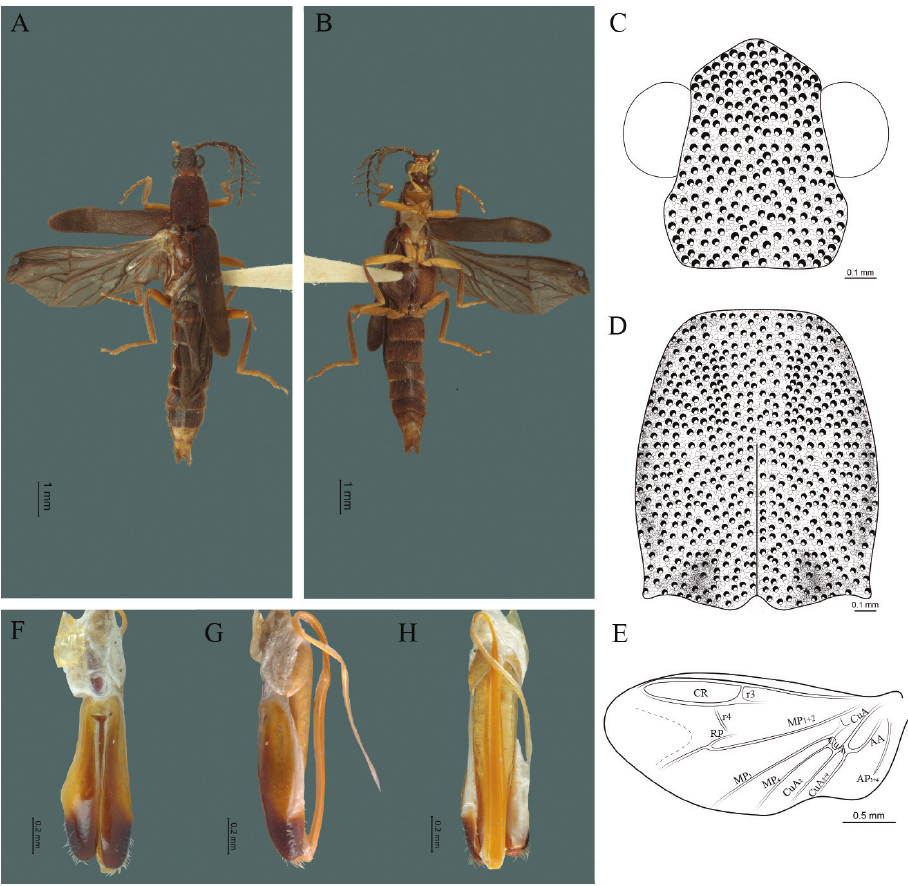
Figure 25. Cenophengus punctatissimus Wittmer, 1976, male. Habitus: A dorsal B ventral C head dorsal D pronotum dorsal E hind wing. Wing venation: CR = Radial Cell; r3 = radial 3 vein; r4 = radial 4 vein; RP = Posterior Radial vein; MP1+2 = Posterior Median vein; CuA = Cubital vein; AA and AP = Anterior and Posterior Anal veins. Aedeagus: F dorsal view G lateral view H ventral